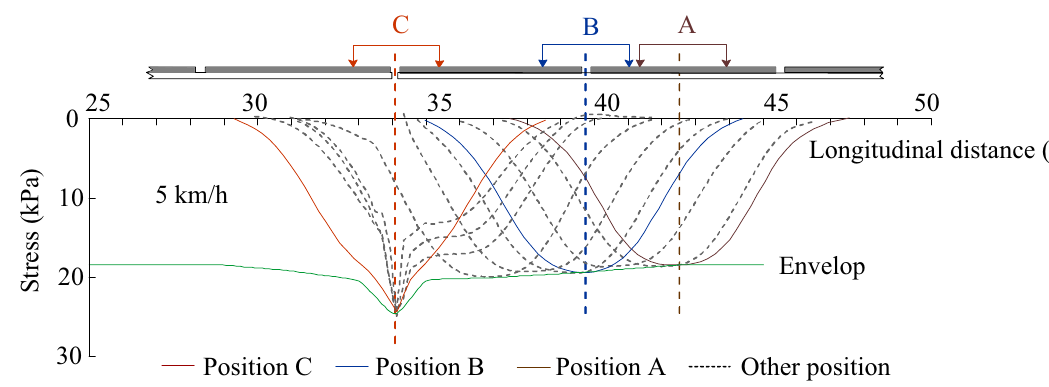
Fig. 12 Stress pattern on roadbed and the envelop of stress peaks